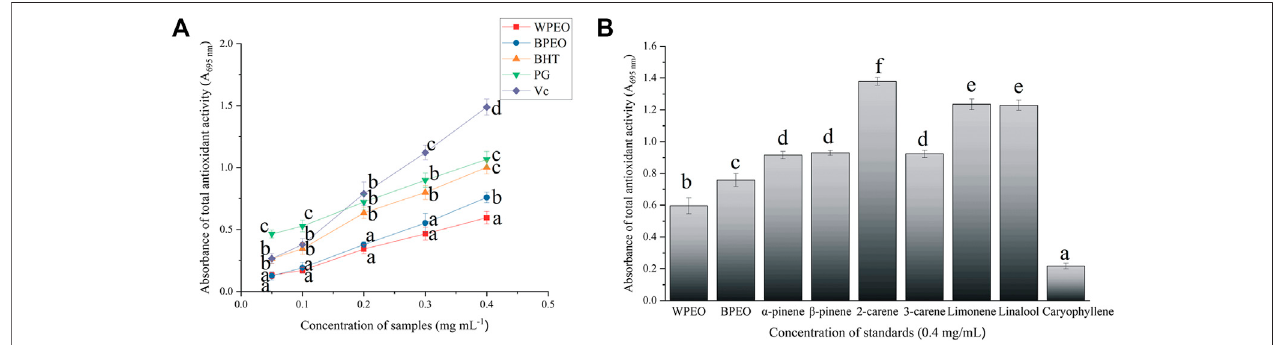
FIGURE3| Thetotalantioxidantactivities(TAA)ofWPEO,BPEO,and syntheticantioxidants(BHT, PG,andVc) (A) andsevenstandards (B) .(Dataarereportedas the mean ± SD ofthree replicates. Barsand lines with different letters are signi fi cantly different at p ≤ 0.05according toone-wayANOVA; WPEO, whitepepperessential oil; BPEO, black pepper essential oil; BHT, butylated hydroxytoluene; PG, propylgallate; Vc, ascorbic